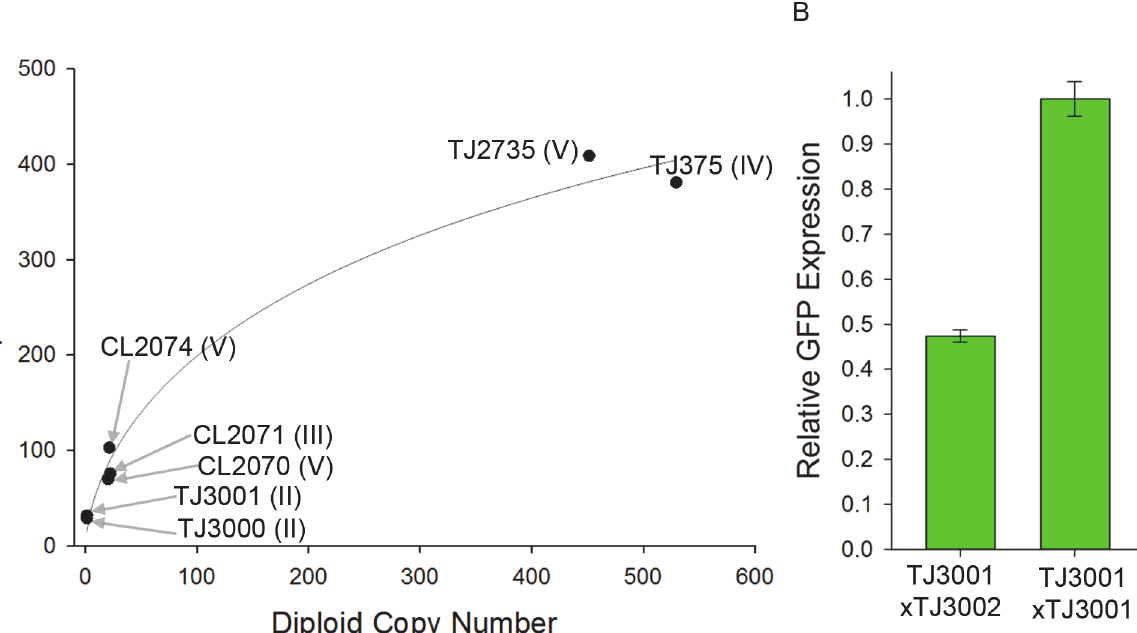
Fig 1. Relationship between copy number and expression in P hsp-16.2 -XFP reporter strains. A) X axis is reporter diploid copy number; Y axis shows expression level in PMT counts. Solid line shows a Hill function with a Hill coefficient of 0.6 (a quantitative measure of the nonlinear increase in expression with increasing copy number), fit to the data with an R 2 of 0.97. For each strain, the expression data is the average of at least three flow experiments that quantified about 500 animals per experiment. B) Average expression level of a single copy P hsp-16.2 -GFP reporter in homozygotes and heterozygotes. Error bars show S.E.M. We picked over 200 F1 hermaphrodites from each cross and measured 84 F1 heterozygotes and 49 F1 homozygotes in flow; additional details in S1 Text, Section 5: Strain Construction.